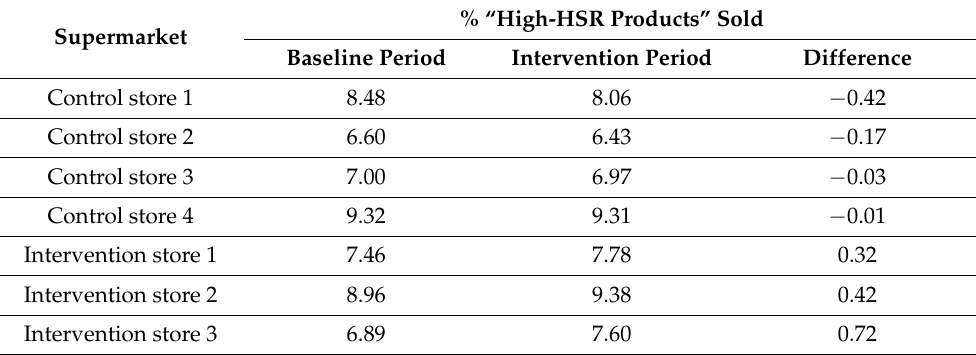
Table 1. Mean percentage of units of ‘high-HSR products’ sold (relative to the number of units of all packaged food sold) in control and intervention